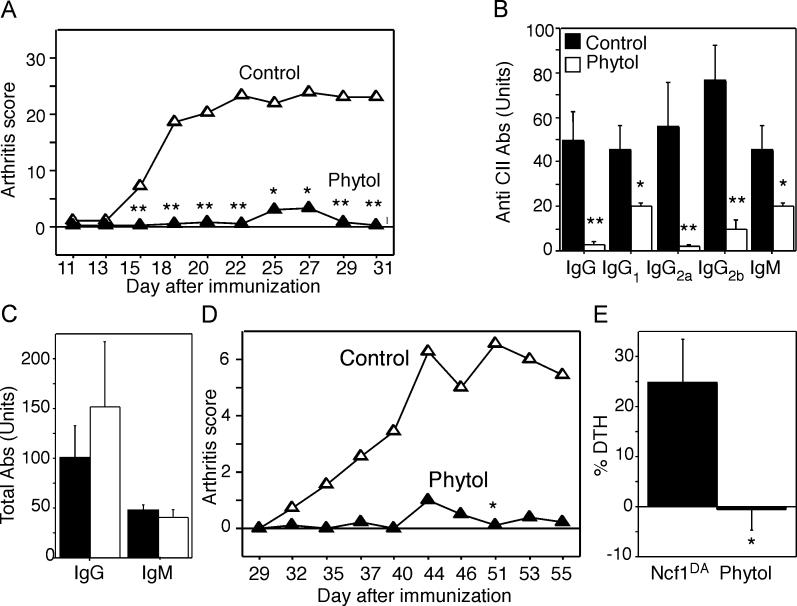
Phytol Suppresses Type II Collagen Autoimmunity(A) Phytol prevents collagen-induced arthritis in DA.Ncf1
DA rats. Effect of SC administration of phytol (200 μl) 5 d before immunization with CII (n = 7).(B) Phytol decreases anti-CII antibody levels in plasma. At day 27 after immunization, plasma samples were taken and analyzed for anti-CII IgG and IgM levels (n = 7). Titres are relative to pooled positive plasma (units).(C) Phytol does not decrease total antibody levels. Total levels of IgG and IgM in plasma taken day 27 after immunization compared to pooled positive plasma (n = 7).(D) Phytol reduces arthritis severity also in NOCIA, an arthritis model induced without involvement of oil. Preventive effect on arthritis of phytol injection (200 μl SC) 5 d prior to induction of NOCIA in DA.Ncf1
DA rats (control n = 7; phytol n = 8).(E) DTH response is abolished after phytol injection. Day 67 after NOCIA immunization the immune system was challenged by an injection of CII in the ear. Subsequent increase in ear volume was measured and compared to control ear (control n = 7; phytol n = 8).*p < 0.05, **p < 0.01.